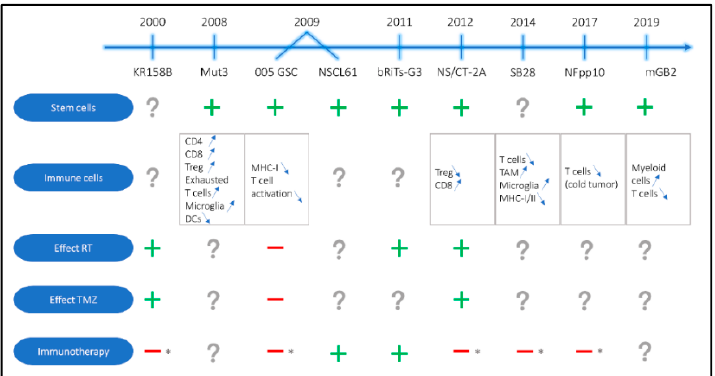
Figure 2. Schematic and chronological presentation of the more recent preclinical immunocompetent mouse models for glioblastoma with information about stemness, immune cell composition, the effects of standard of care and the efficiency of immunotherapy. RT: radiotherapy, TMZ: Temozolo- mide, Treg: regulatory T cell, DC: dendritic cell, MHC-I/II: major histocompatibility complex I or II, TAM: tumor associated macrophage, (+) presence of stem cell populations and/or positive effect of treatment administration, ( − ) no effect of treatment administration, (?) data not available in literature and (*) resistance to immune checkpoint